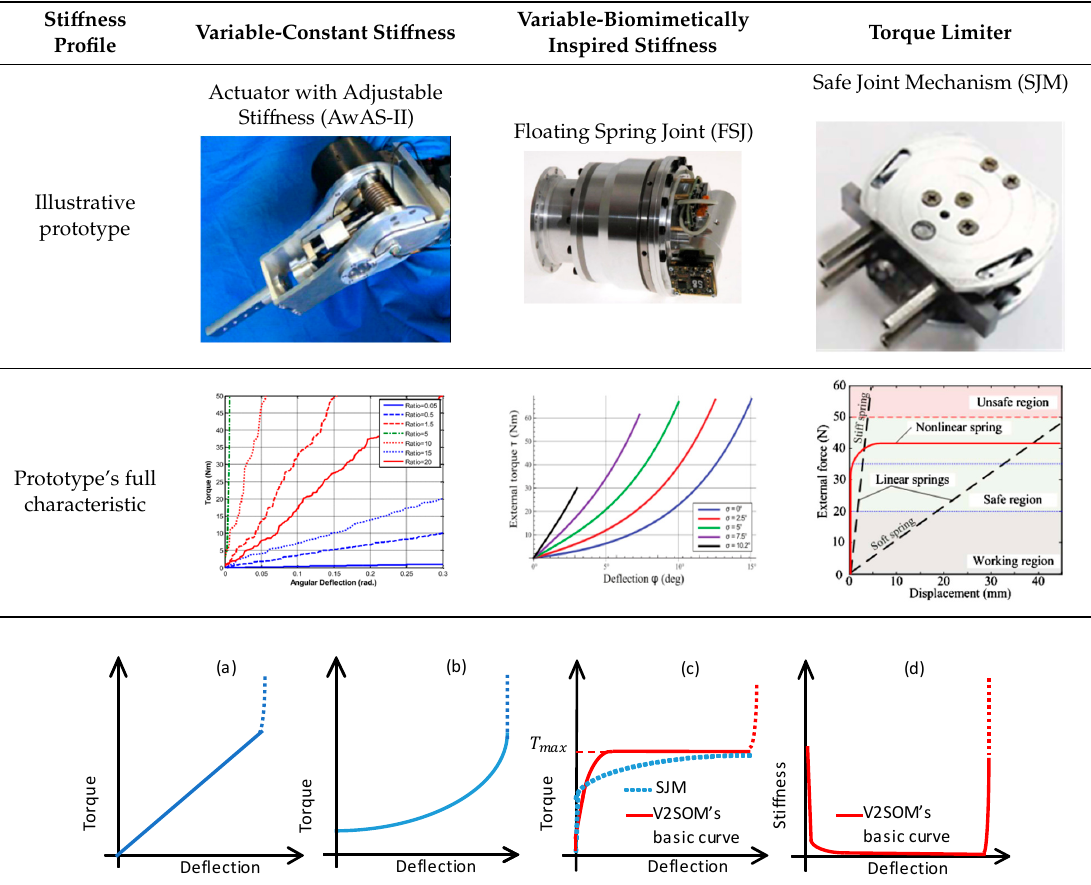
Figure 2. Different basic torque curves and V2SOM stiffness curves: ( a ) Constant stiffness, ( b ) Biomimetically inspired stiffness, ( c - d ) V2SOM basic curves.